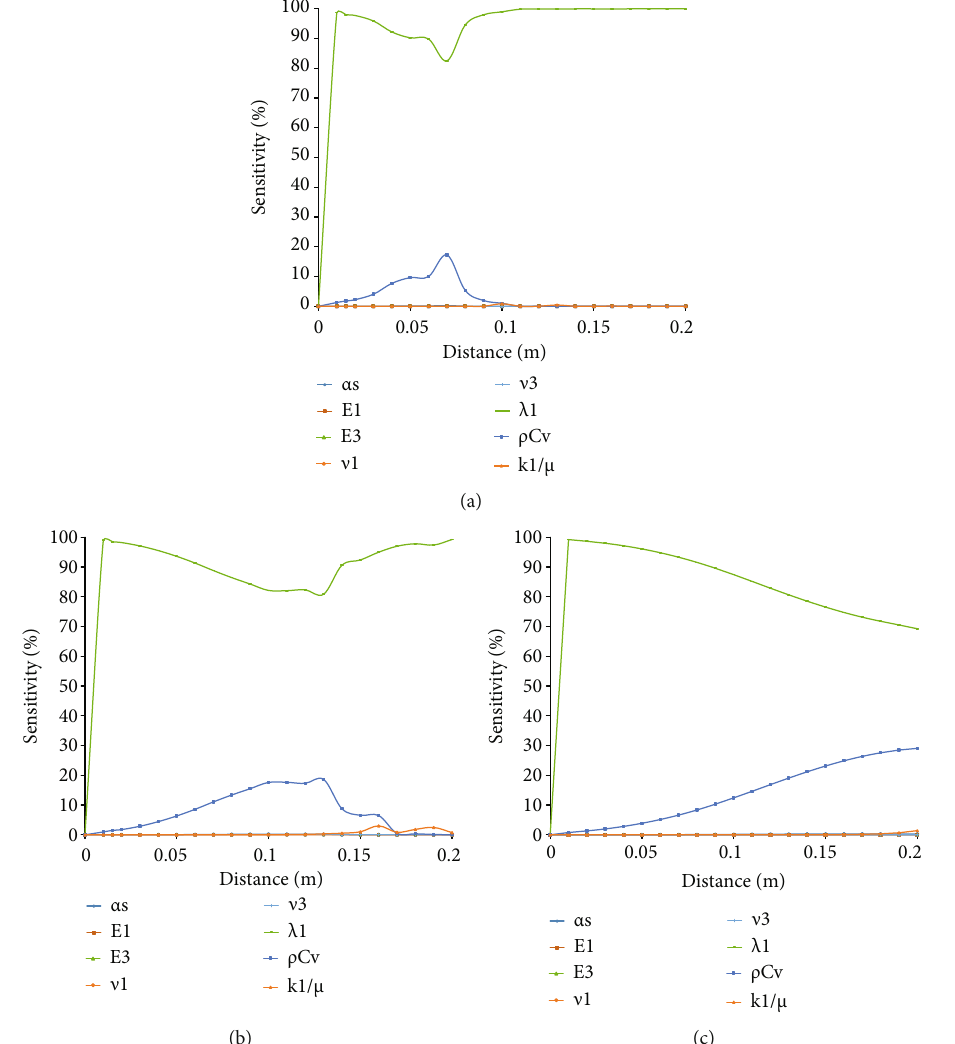
Figure 8: Sensitivity ranking for temperature in the fracture at time (a) t = 15 (min), (b) t = 30 (min), and (c) t = 60